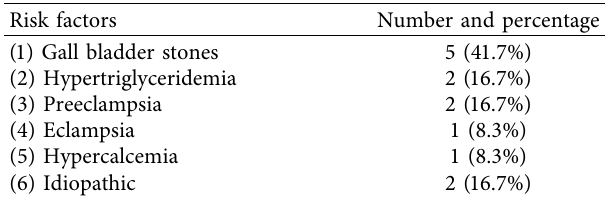
Table 2: Risk factors associated with acute pancreatitis in pregnancy.